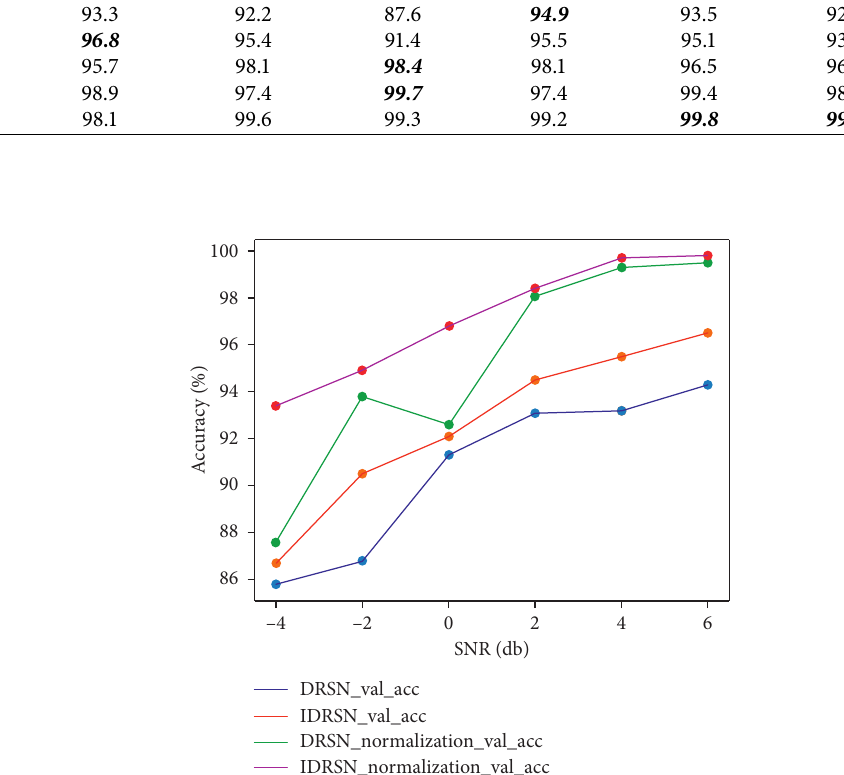
Figure 9: Comparison of accuracy results of normalized IDRSN, normalized DRSN, IDRSN, and DRSN under different noise intensities.